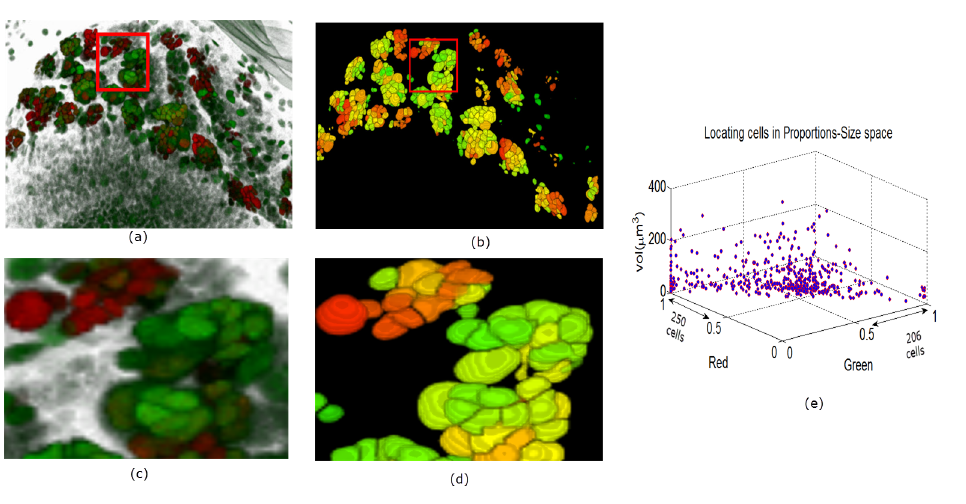
Figure 9. Panel ( a ) shows a 3D view of a WILD TYPE laval brain nuclei. In panel ( b ), the 3D segmentation is rendered in ImageJ. In panels ( c ) and ( d ) enlarged portions are shown from the original and reconstructed images. Panel ( e ) shows the quantitative characteristics of the nuclei in the